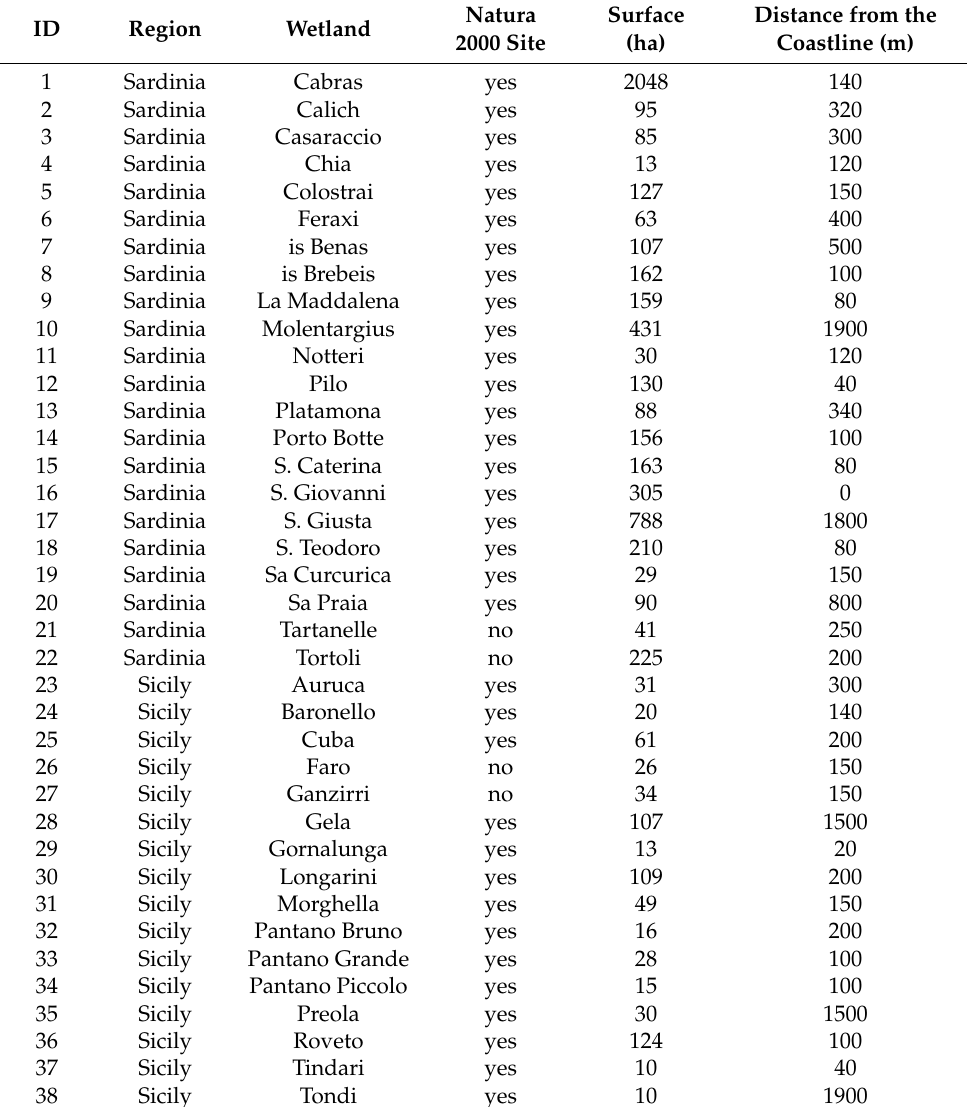
Table 1. Description of the 38 wetlands selected in Sardinia and Sicily